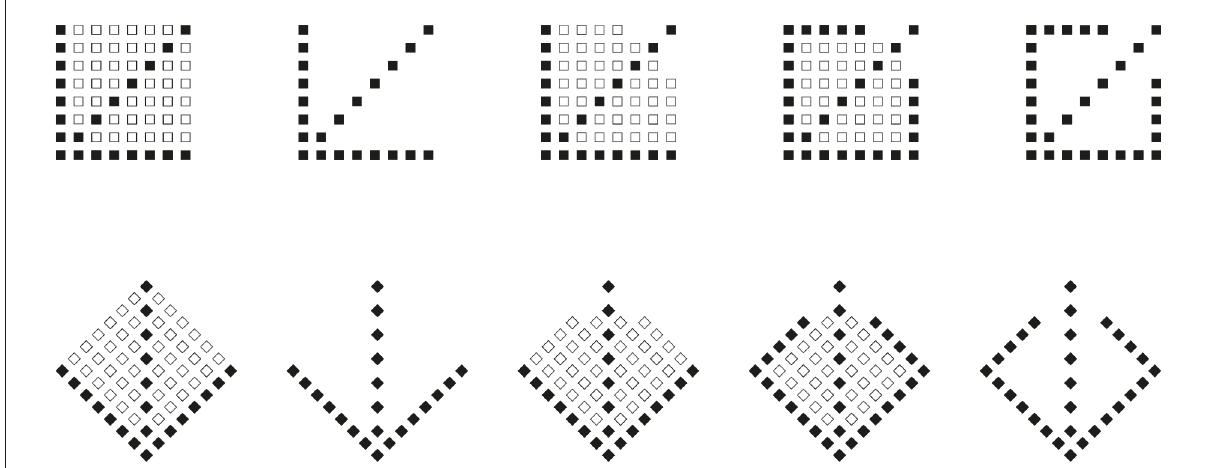
FIGURE12 Squares and diamonds perceived as squares and diamonds (first row); squares perceived as diamonds and diamonds perceived as rotated squares (second row).